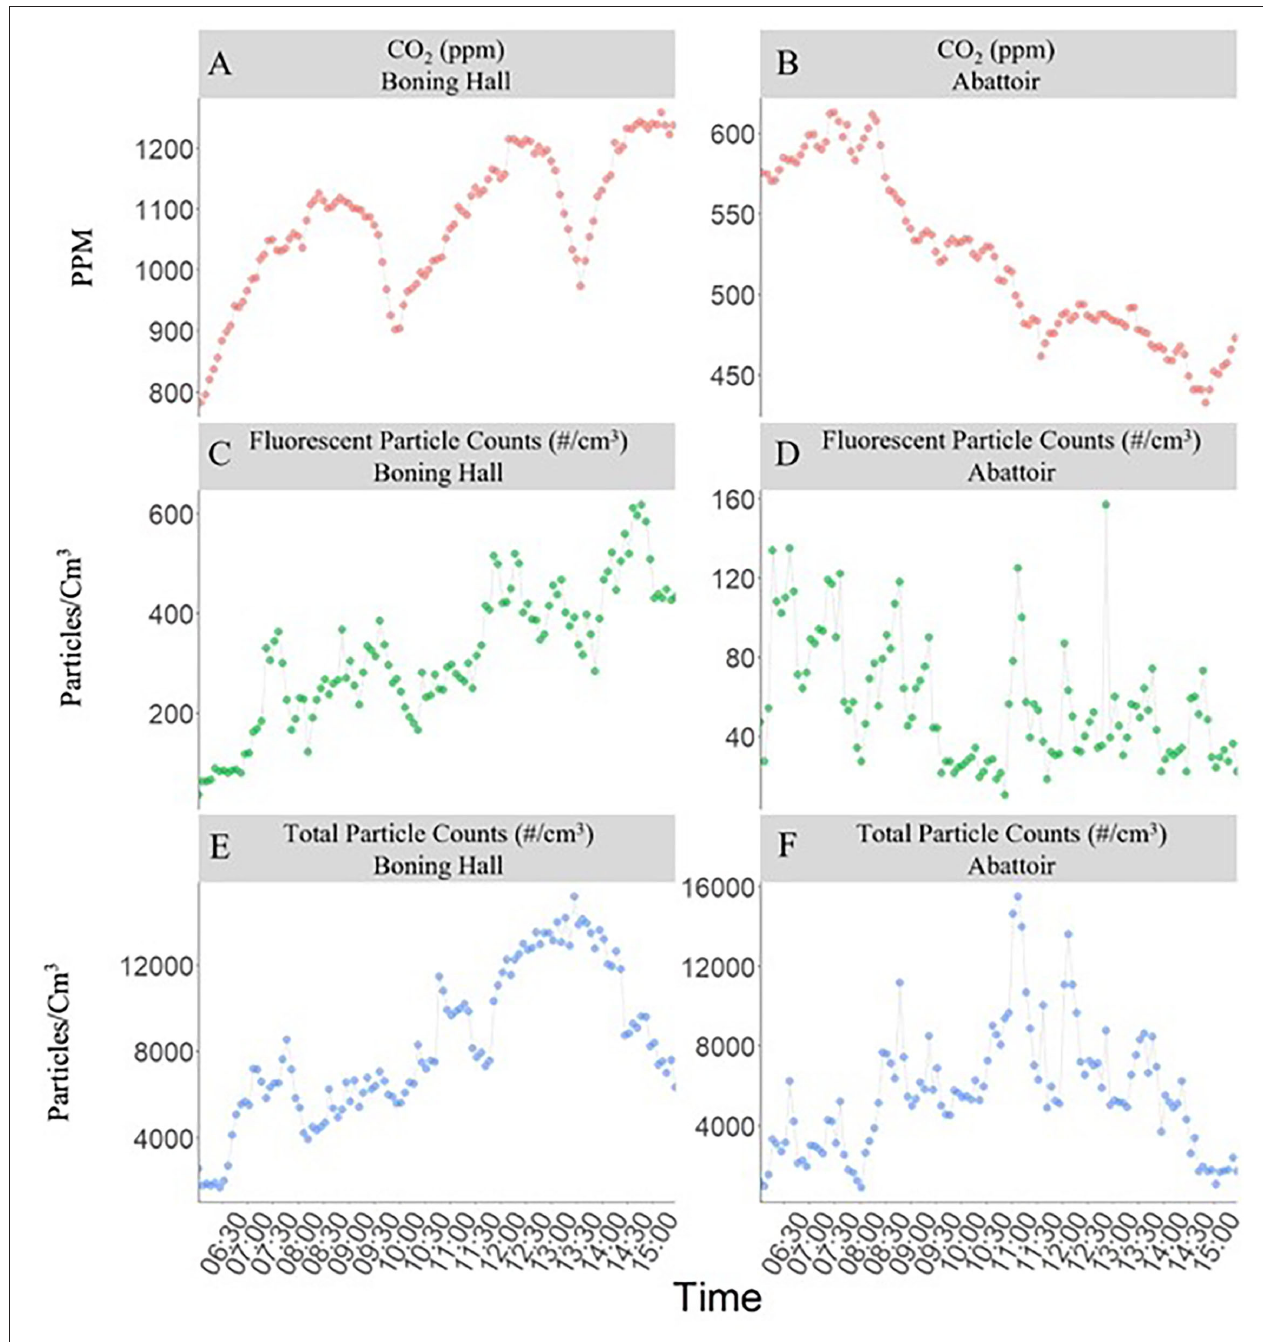
FIGURE 3 | Average CO 2 concentrations (A,B) , flourescent particle number concentration (C,D) and total particle counts (E,F) measured during the daytime working shifts (07:00–15:00) in the boning hall (over 3 days) and abattoir (over 2 days).